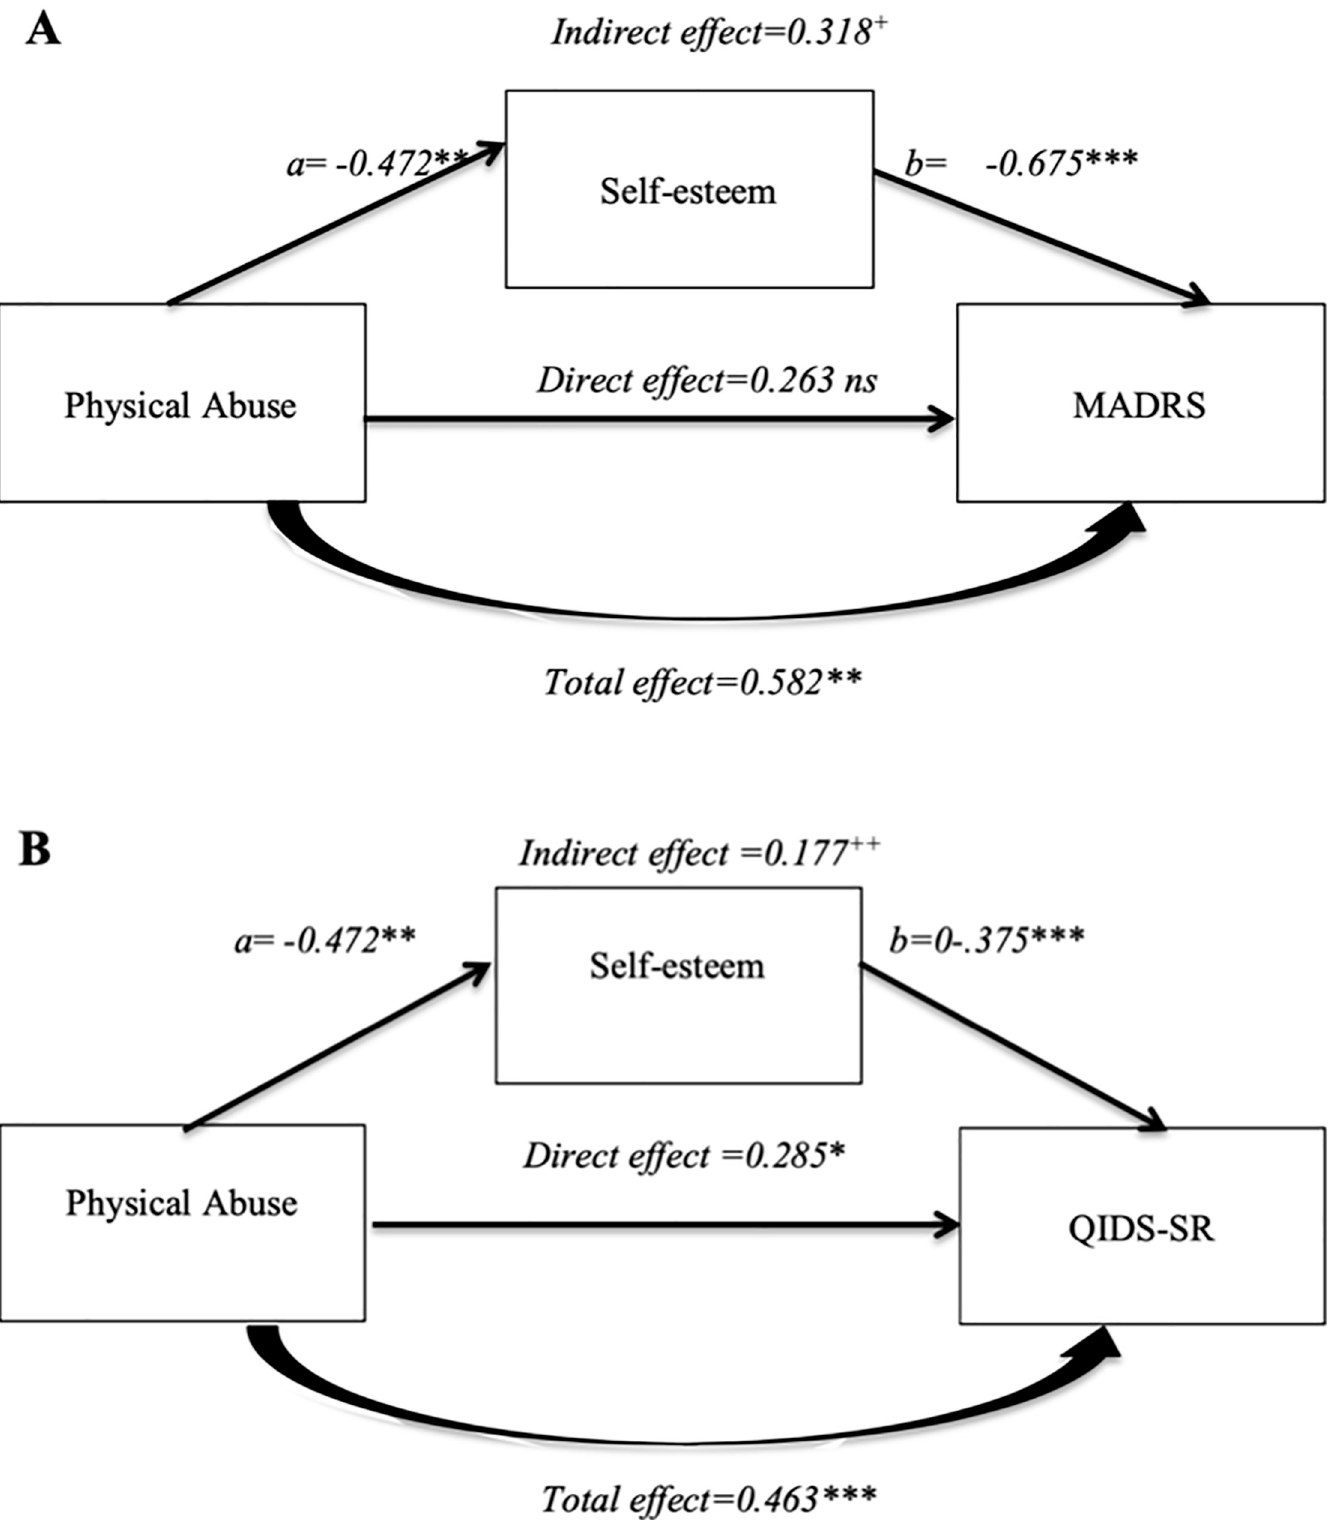
Fig 4. Self-esteem as mediator of physical abuse on intensity of depressive symptoms: A: MADRS; B: QIDS.